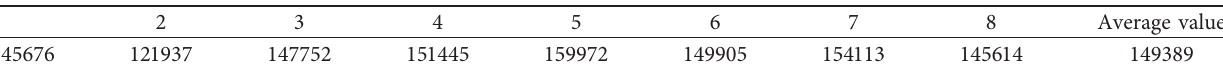
Figure 10: Number of each Table 8: Optimization results of LLH3.